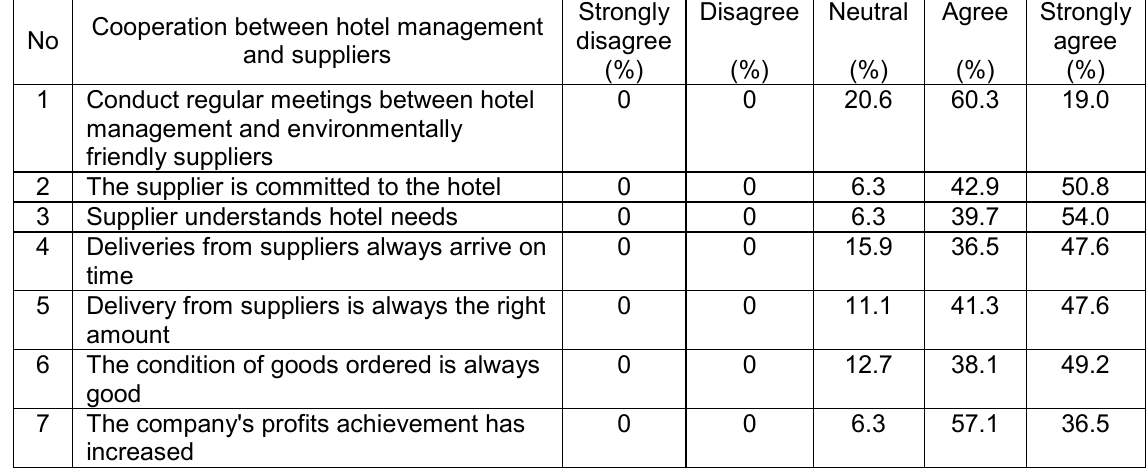
Table 5. Cooperation between hotel management and